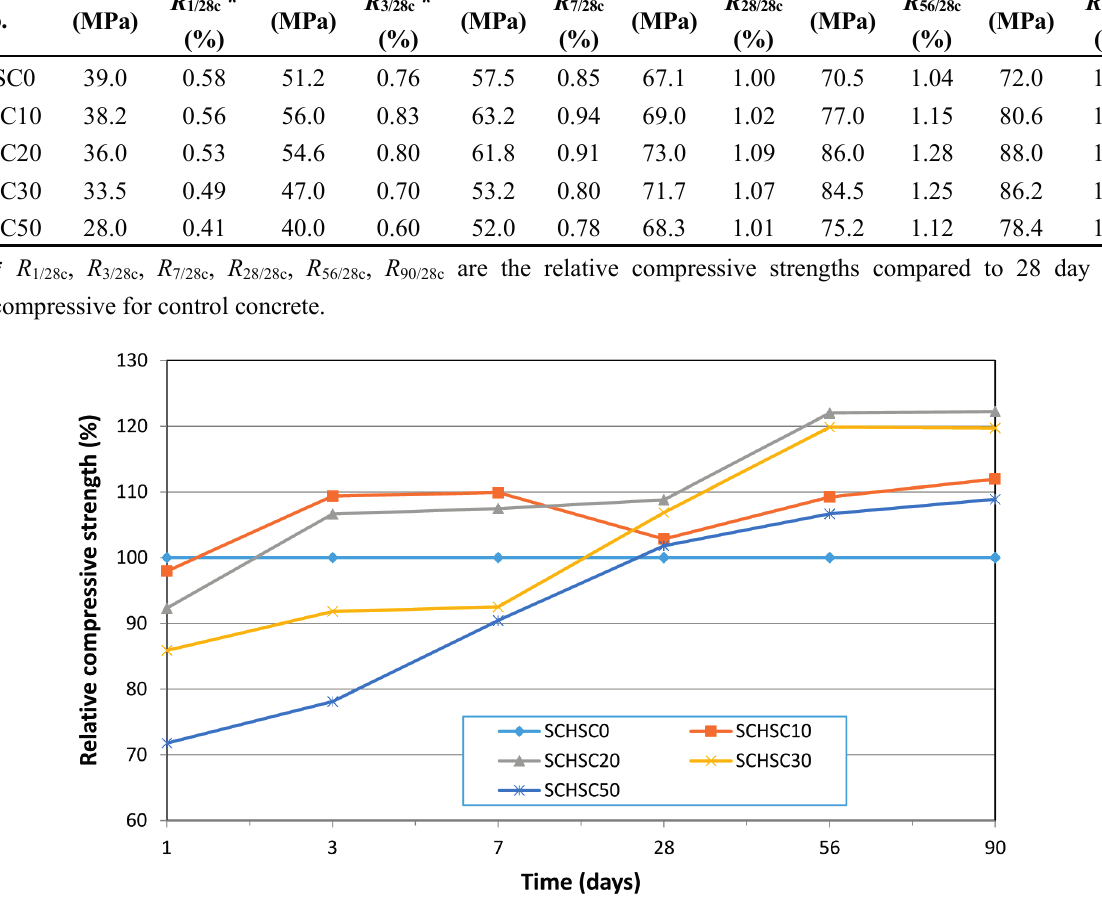
Figure 10. Relative compressive strengths of SCHSCs with different treatment of POFA